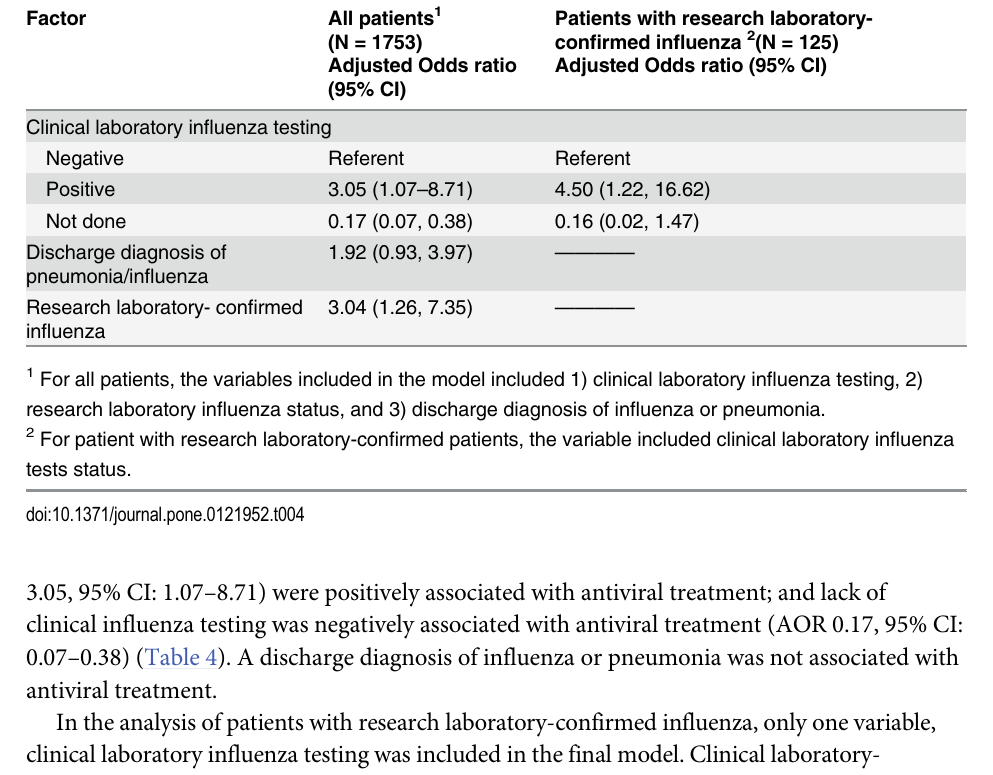
Table 4. Independent factors associated with antiviral treatment among adults, 50 years and older, hospitalized with symptoms of acute respiratory illness or non-localizing fever, and those with re- search laboratory-confirmed influenza, 2006 –